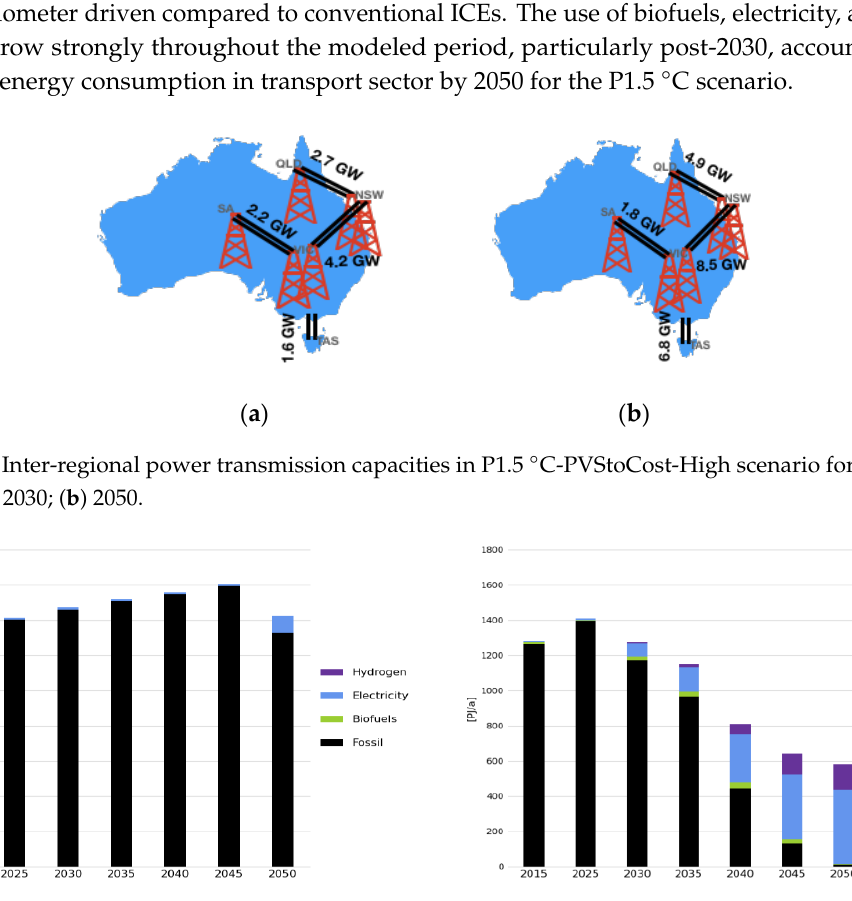
Figure 5. Inter-regional power transmission capacities in P1.5 °C-PVStoCost-High scenario for different years: ( a ) 2030; ( b ) 2050.